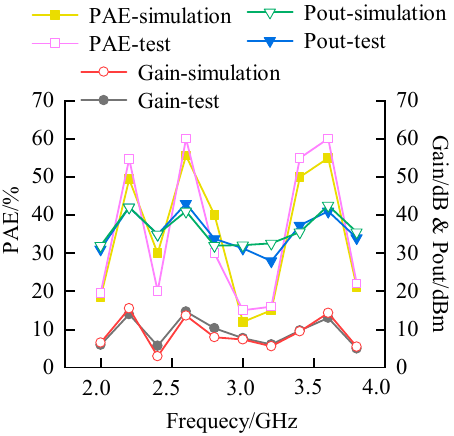
Figure 11. Simulation and test results of power addition, power output, and gain at 2.0 GHz to 4.0 GHz.